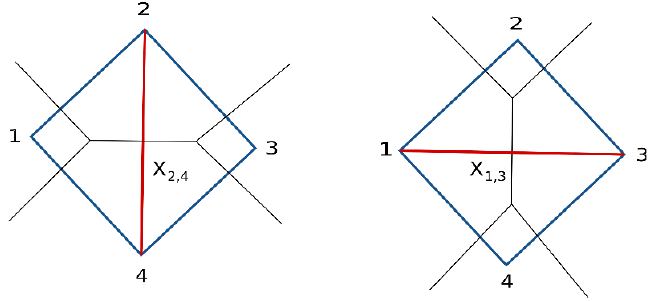
Figure 2 . A planar variable cuts an internal propagator of the Feynman diagram once.